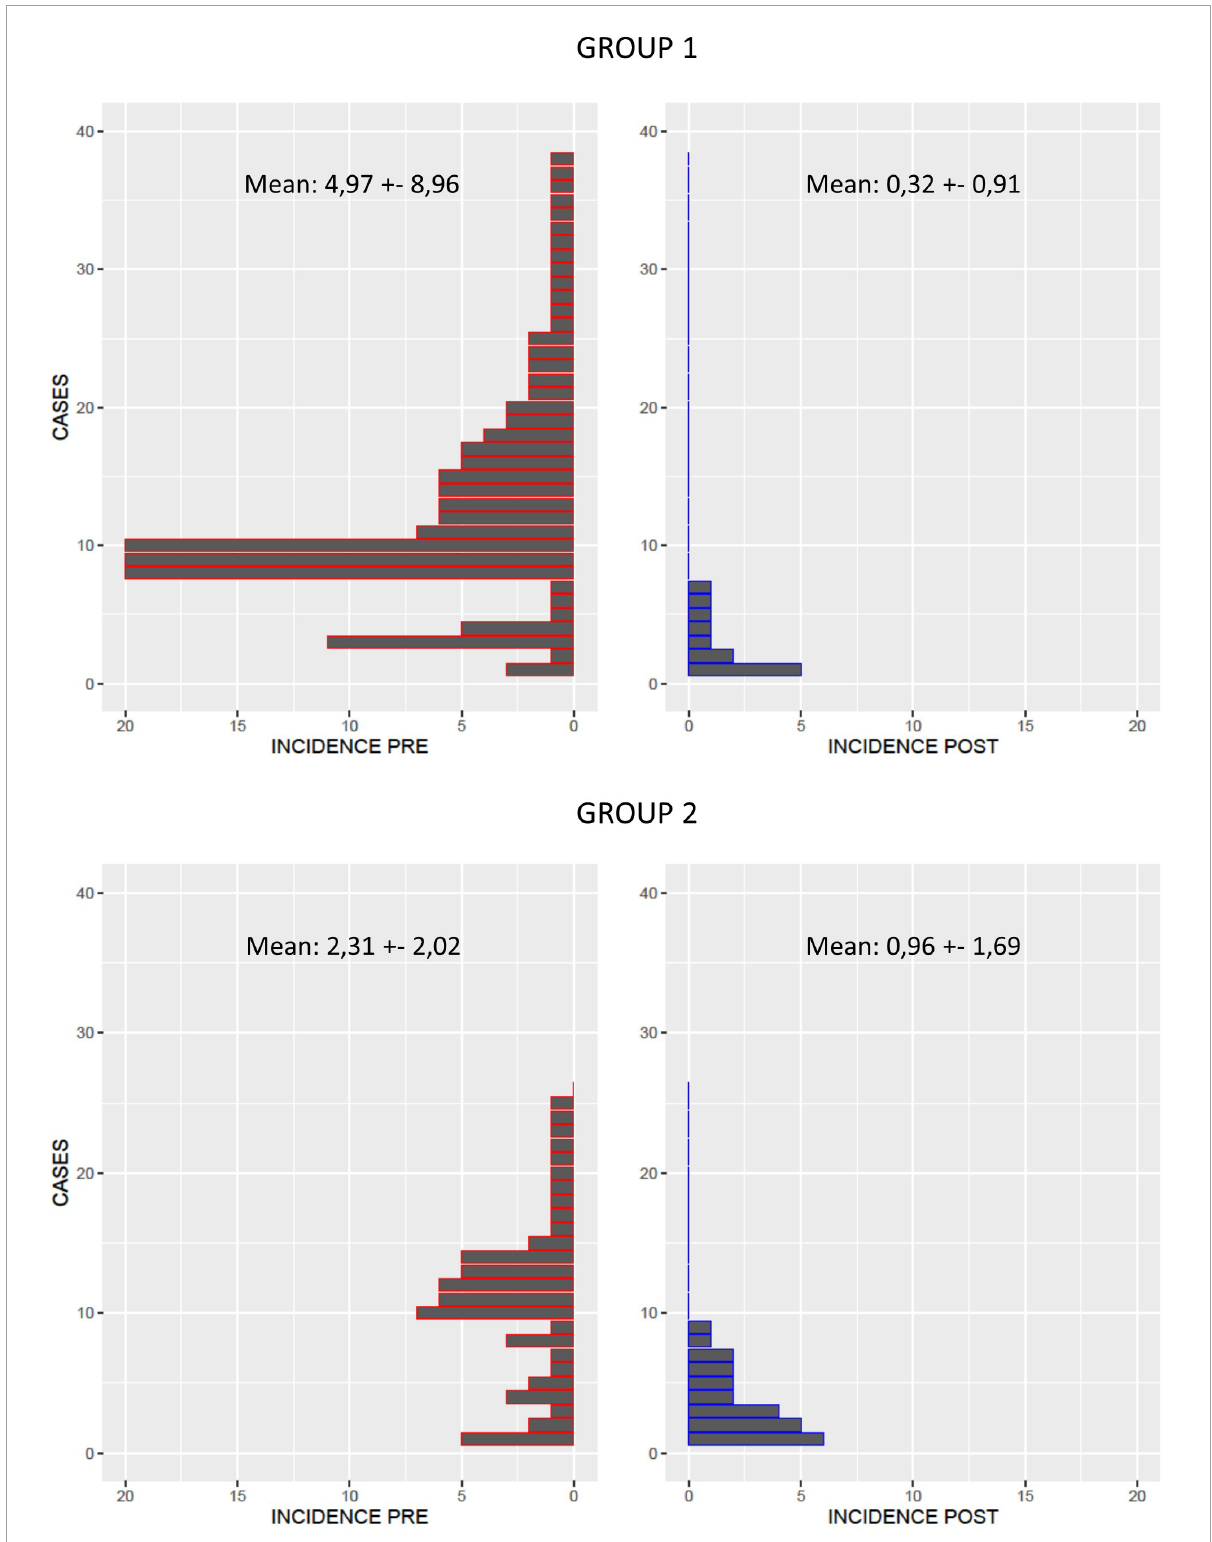
FIGURE1 VT burden before (red) and after ablation (blue) in group 1 (extensive mapping) and group 2 (scar dechanneling). A reduction in VT was observed in both the groups, but the reduction was larger in the extensive HD mapping